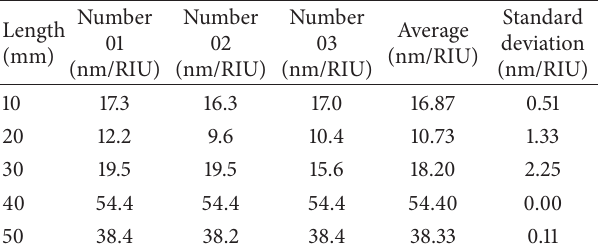
Table 3: Refractive index measurement for various lengths (groove type).